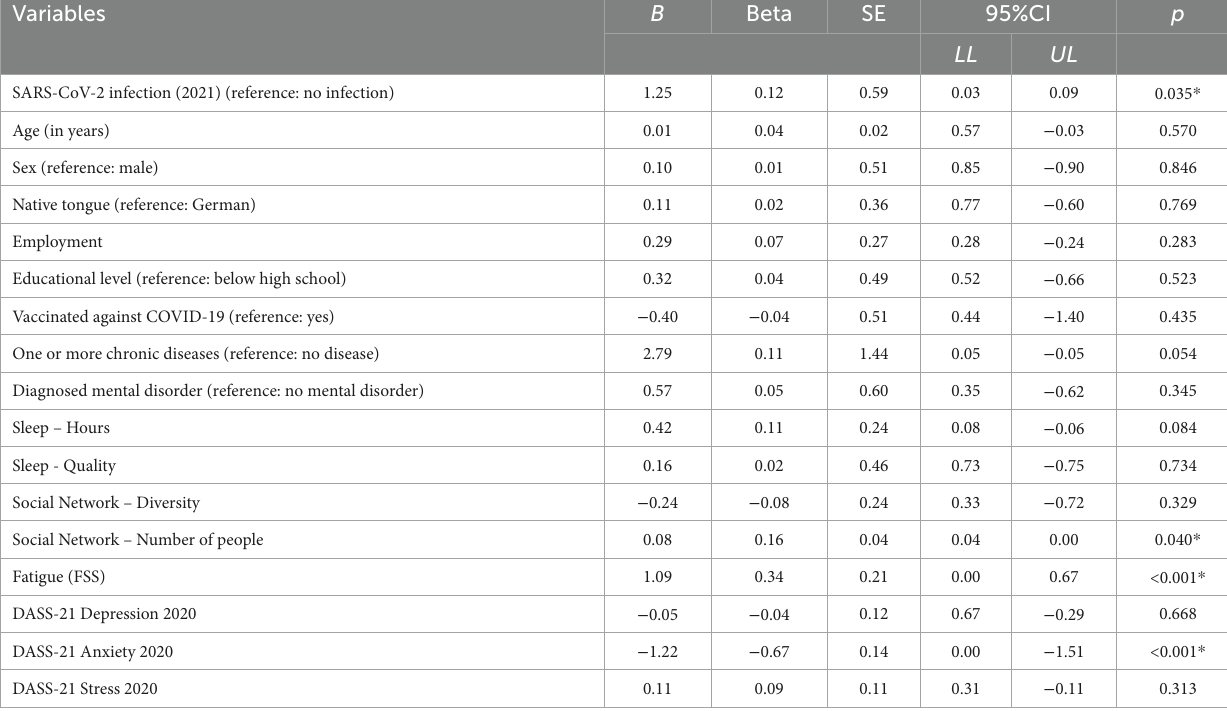
TABLE 5 Multiple linear regression analyses showing the association between confirmed SARS-CoV-2-infection and changes in anxiety (DASS-21 anxiety subscale) between 2020 and 2021 ( n = 305).